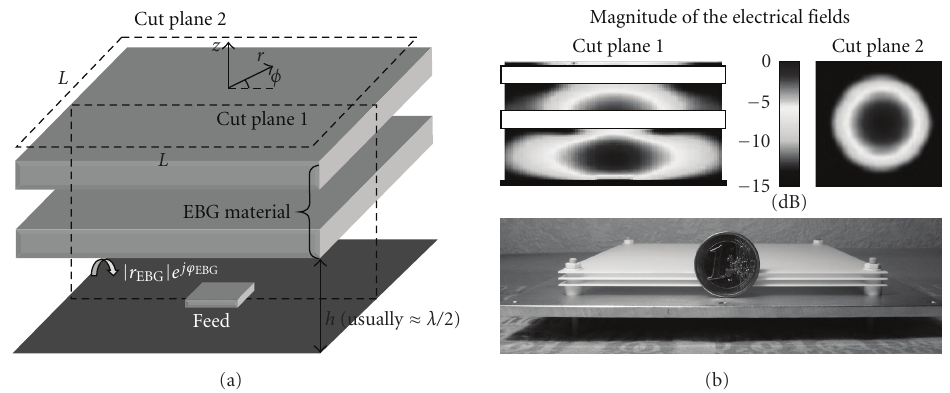
Figure 1: (a) Schematic view of an EBG resonator antenna; (b) EM fields at the operating frequency.